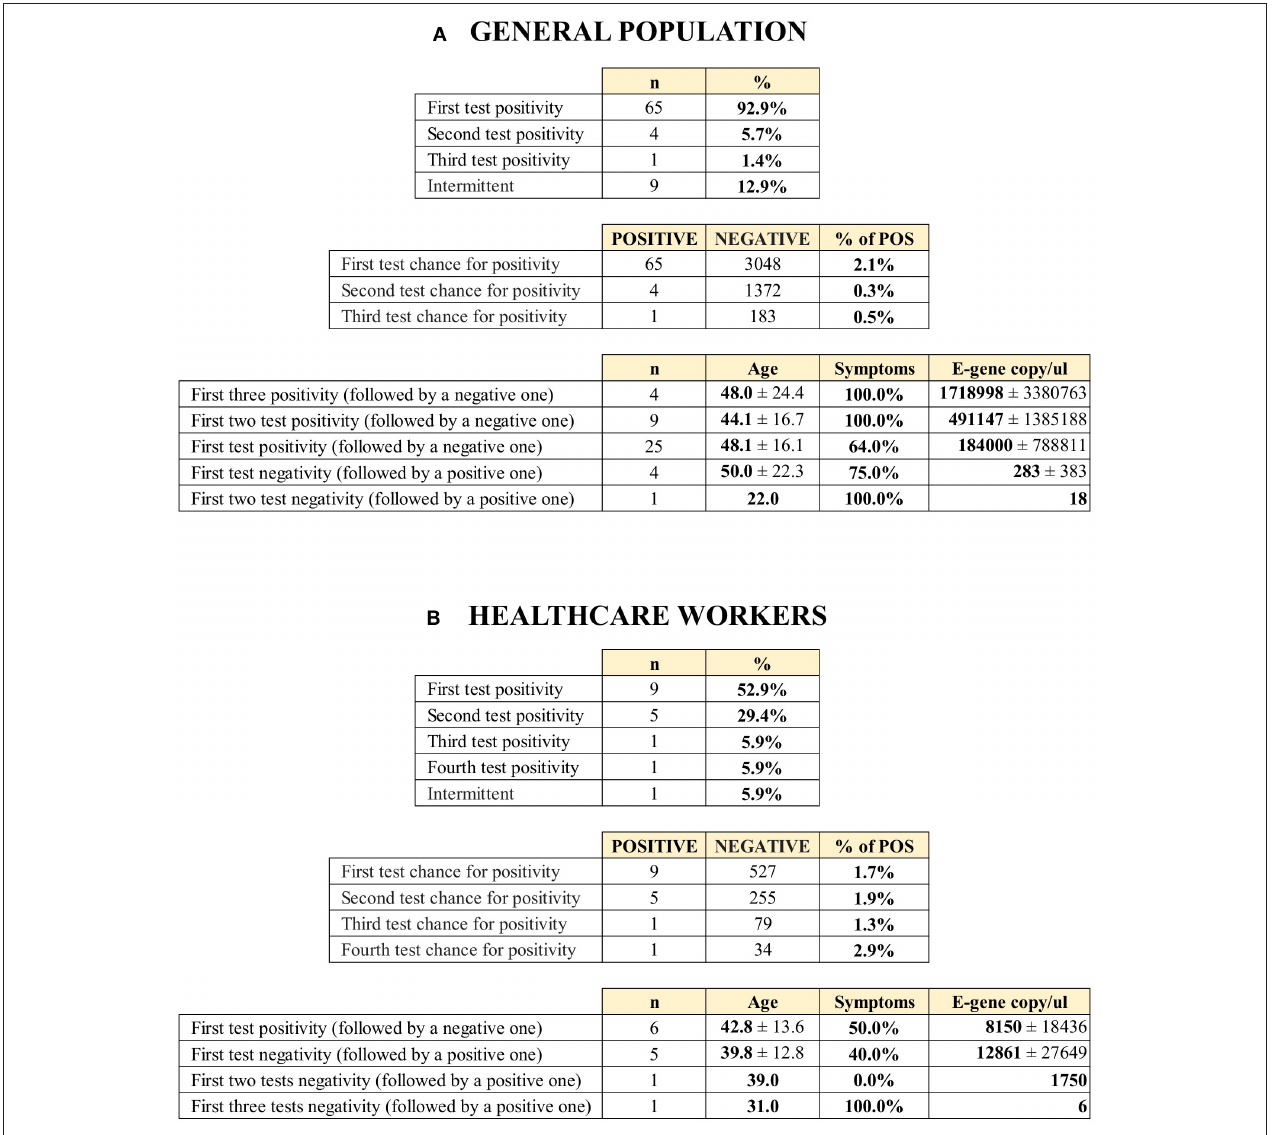
FIGURE 4 | Links between polymerase chain reaction (PCR) positivity with first and subsequent testing and viral excretion among the (A) general population and (B) health care